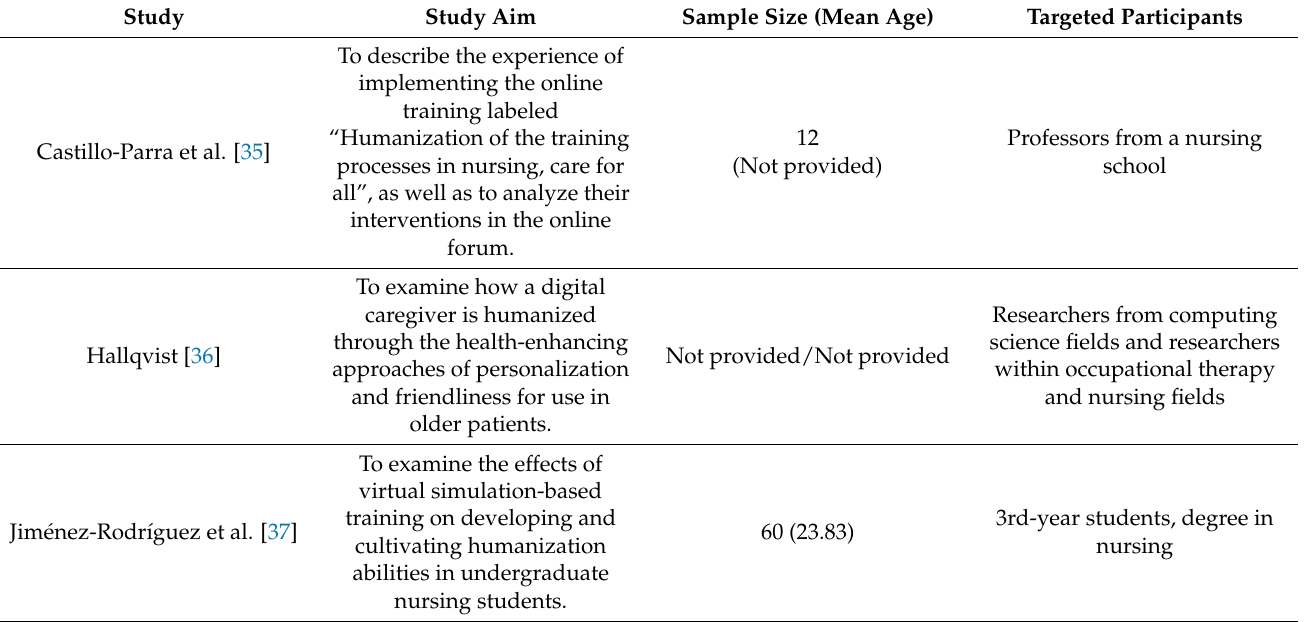
Table 2. General characteristics of studies included (II) ( n =